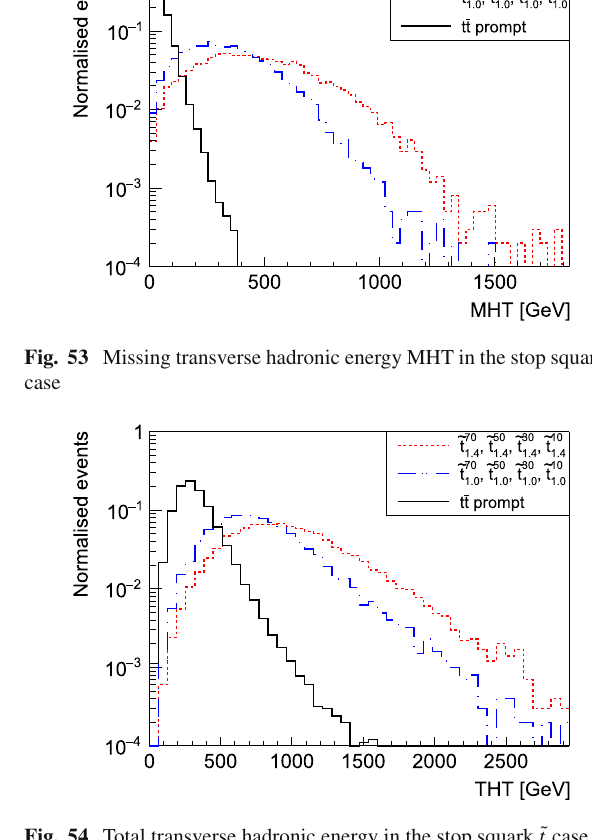
Fig. 51 d z distributions for the eight benchmarks for the long-lived stop squark with a magnetic field of B = 3 . 8 T